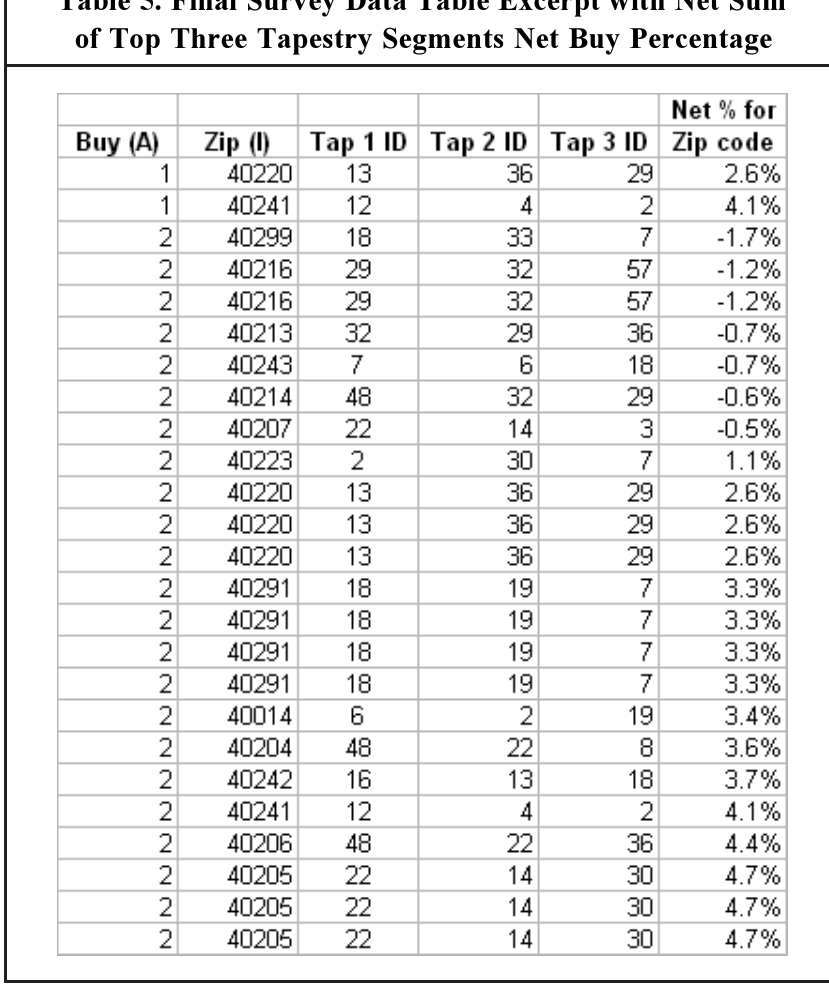
Table 5. Final Survey Data Table Excerpt with Net Sum